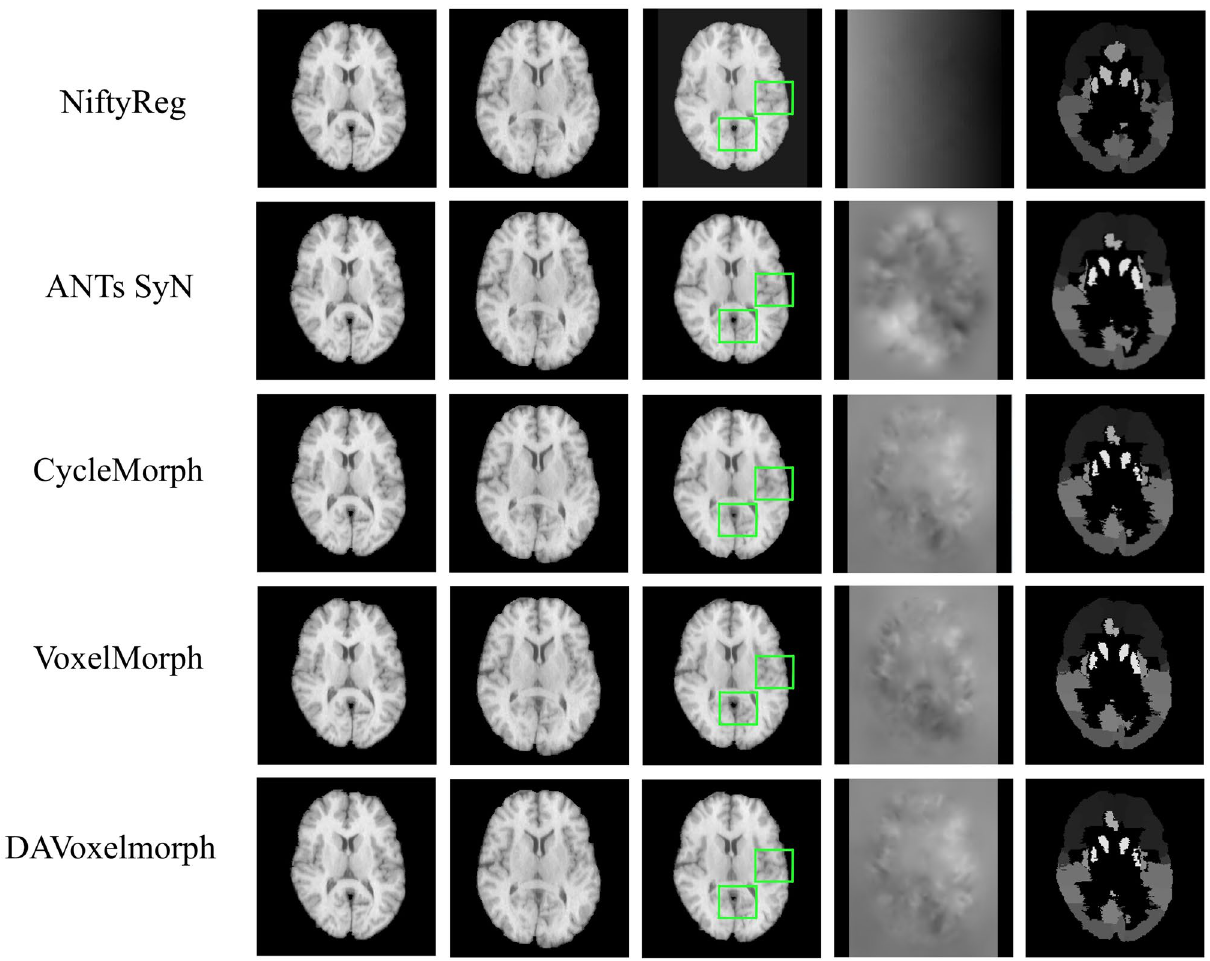
Figure 6. Registration results of different methods on LPBA40 dataset. The first column is the fixed image and the second column is the moving image. The third column shows the moved image after registration and in the area shown in the green box, DAVoxelMorph shows a better registration effect in detail. The fourth and the fifth column show the deformation field during the registration and